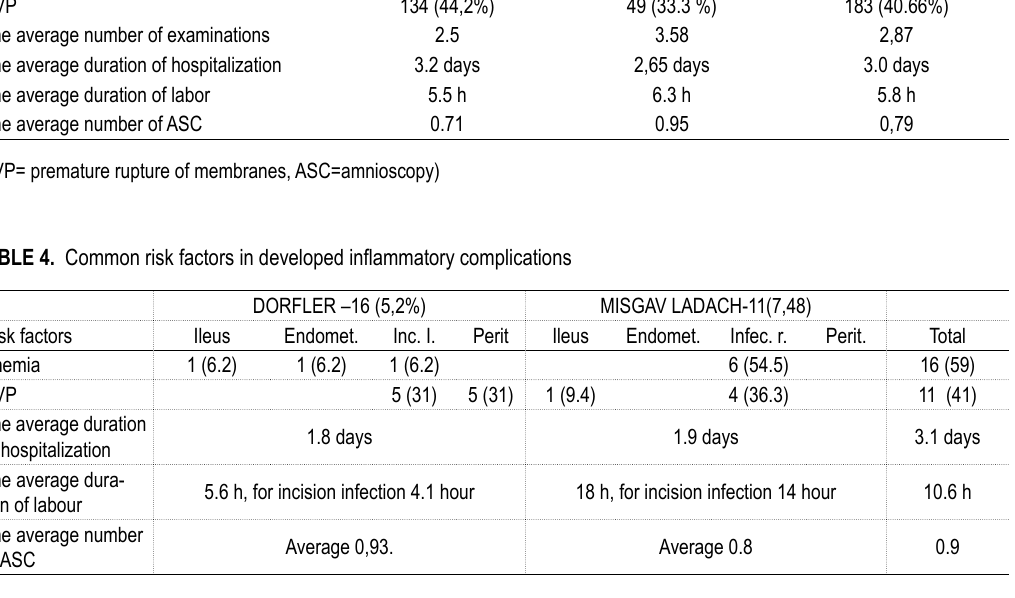
(aSc=amnioscopy, rVP= premature rupture of membranes, Prit..=peritonitis, endomet.=endometritis, inc. i.=incision